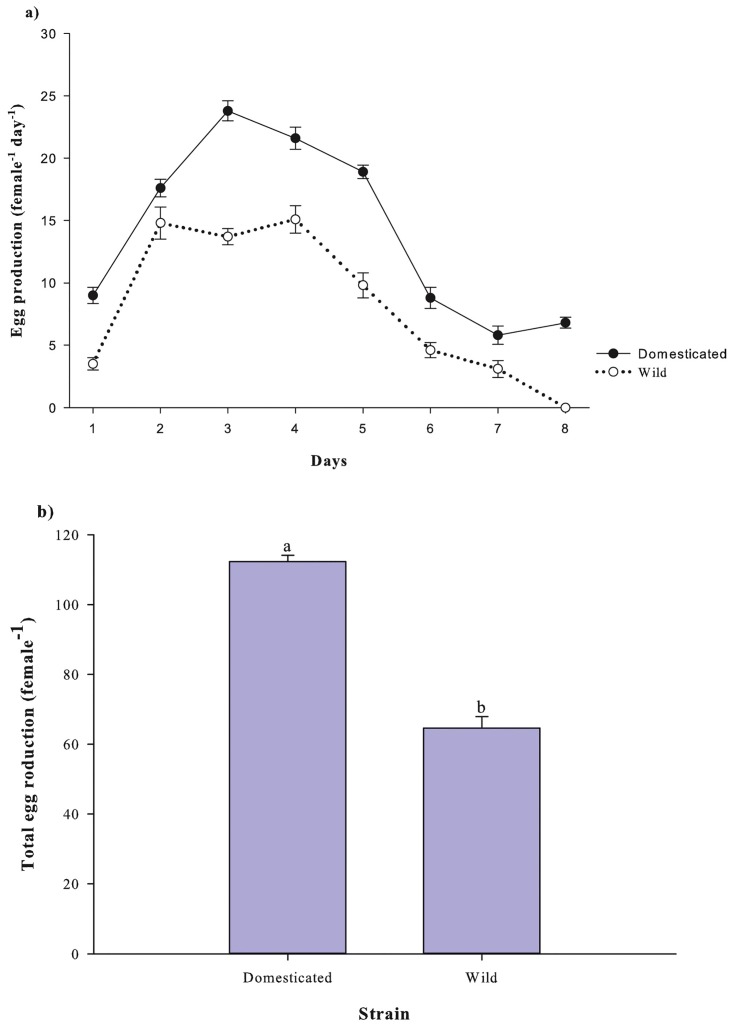
Egg production of P. crassirostris (female-1) strains (n = 10).a) Mean daily egg production female-1 over 8 days; b) mean total egg production female-1 over 8 days. Data are presented as the mean ± standard error. The different letters on the tops of the bars indicate significant differences (p <0.001).